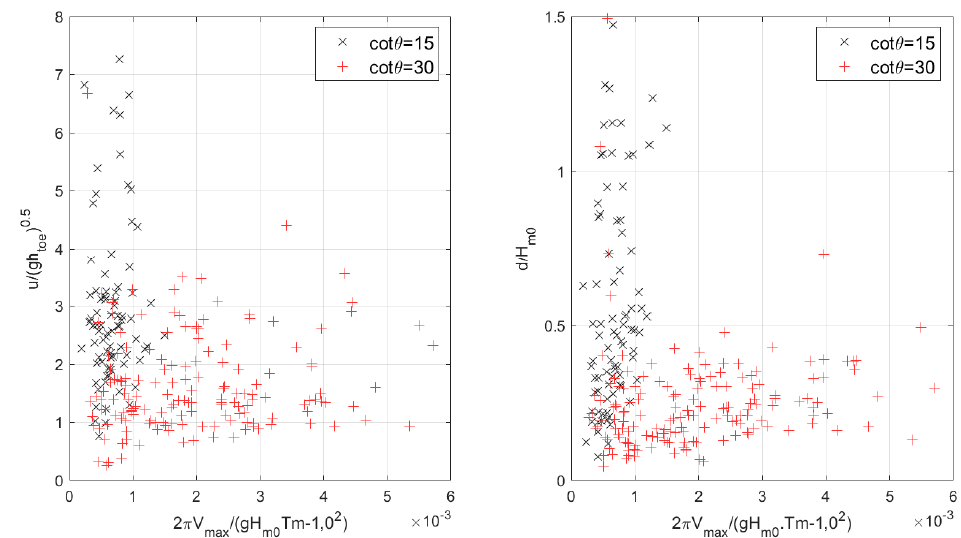
Figure 14. Variation of dimensionless overtopping layer velocity and depth with dimensionless maximum individual overtopping volume for two different foreshore slopes.